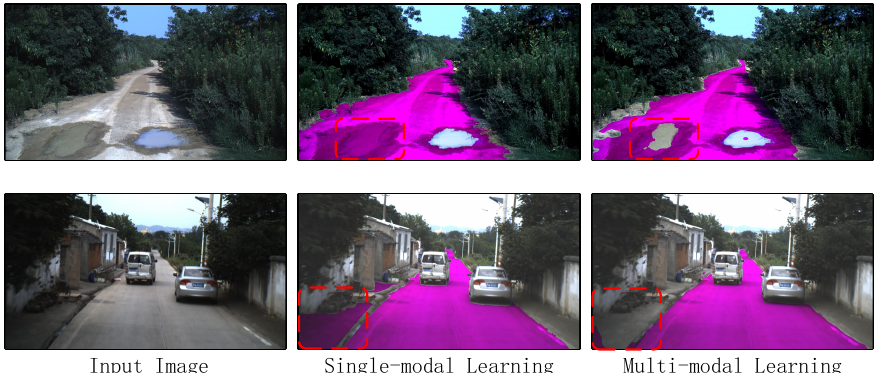
Figure 1. Example of real-world scenarios where current state-of-the-art single-modal approaches demonstrate misclassifications. The first row shows an issue of misclassifications caused by puddles that do not reflect the sky. The second row shows inconspicuous classes where roads and curbs are constructed of the same